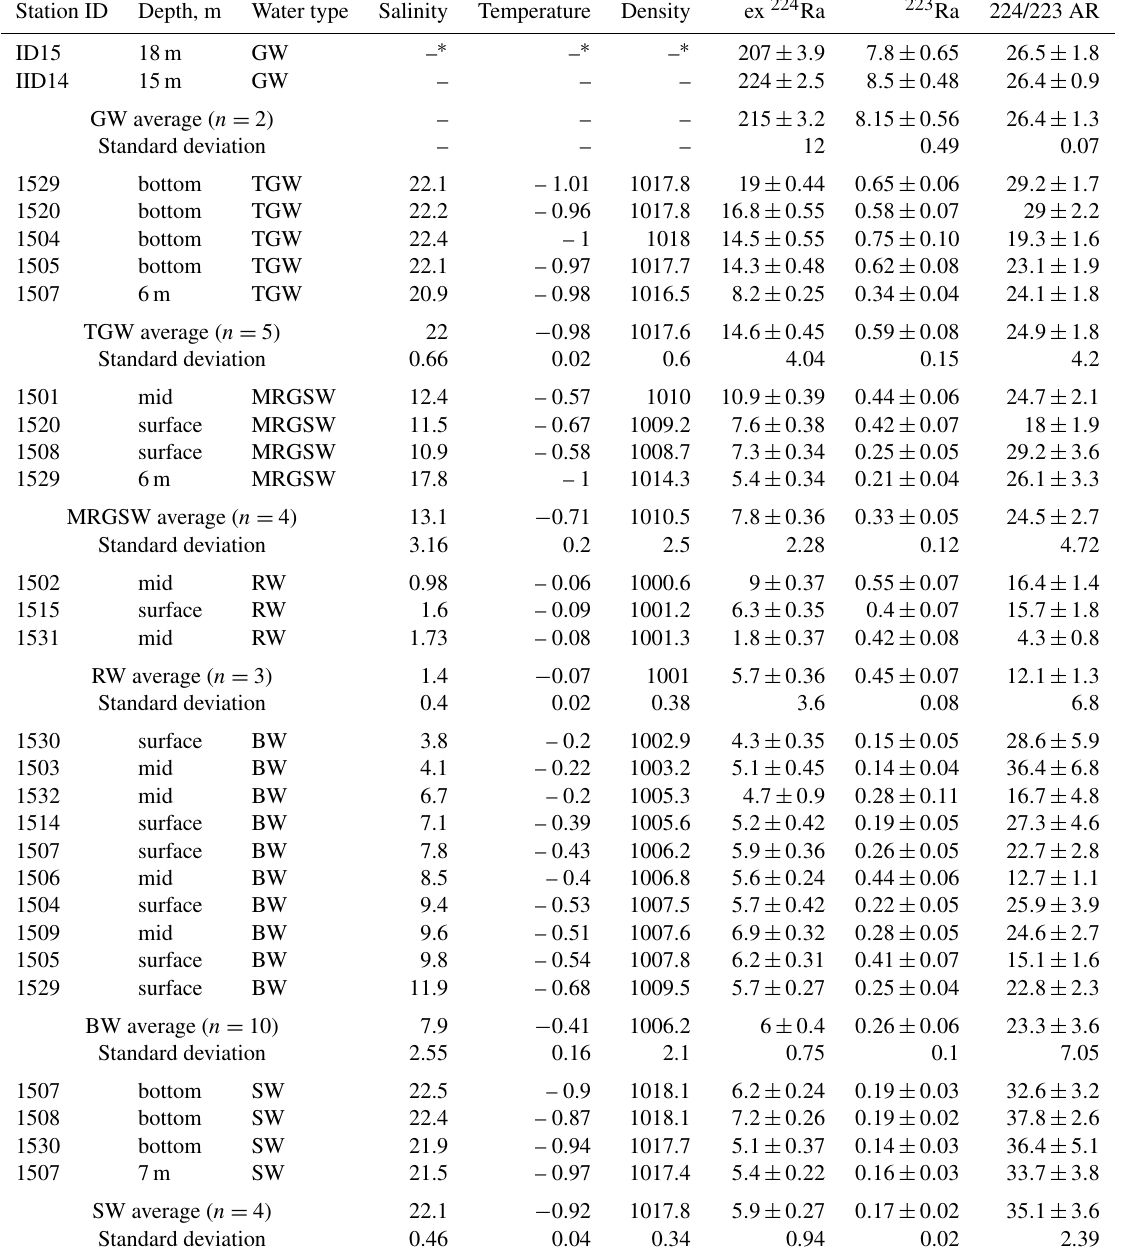
Table 1. Salinity, temperature ( ◦ C), density (kgm − 3 ), activities of short-lived radium ( 224 Ra and 223 Ra) isotopes (dpm100L − 1 ), and 224 Ra / 223 Ra activity ratio at the sampling sites in the western Buor-Khaya Gulf (Laptev Sea) during winter. GW: groundwater, TGW: transformed groundwater, RW: river water, BW: brackish water, SW: seawater, MRGSW: mixture of GW, RW, and